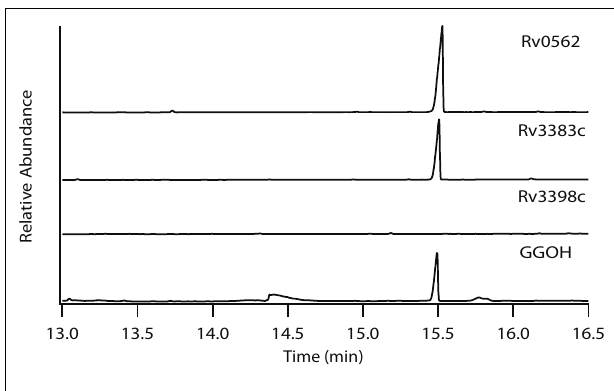
FIGURE 4 | Production of GGPP by Rv3383c and Rv0562. GC-FID chromatogram of GGPP-derived GGOH production in Rv0562 and Rv3383c, but not the previously confirmed ( E,E )-FPP synthase Rv3398c, as compared to dephosphorylated authentic